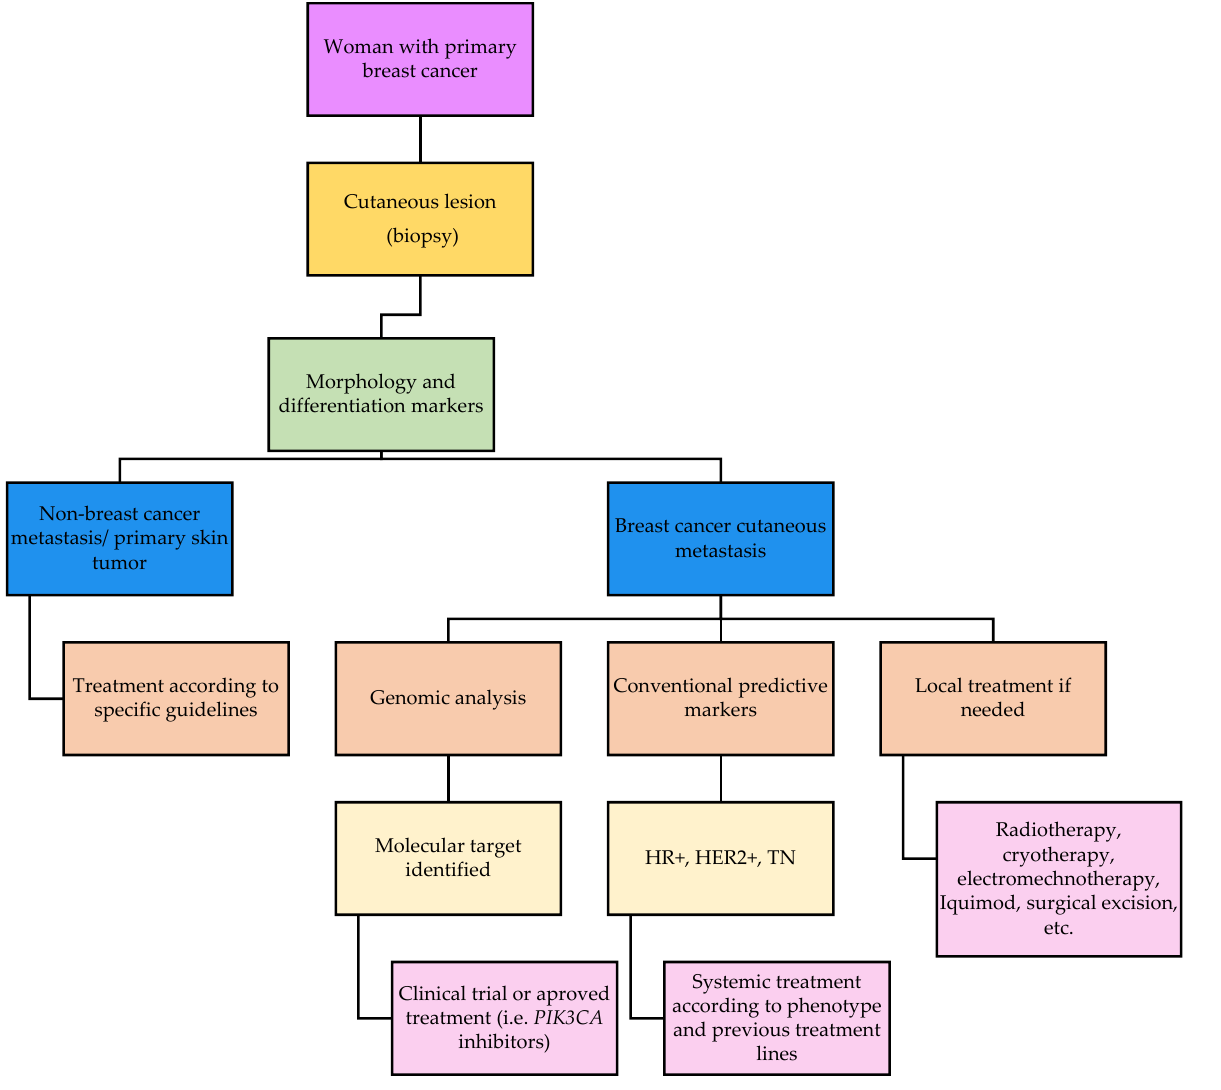
Figure 6. Diagnostic and treatment algorithm for cutaneous metastasis.